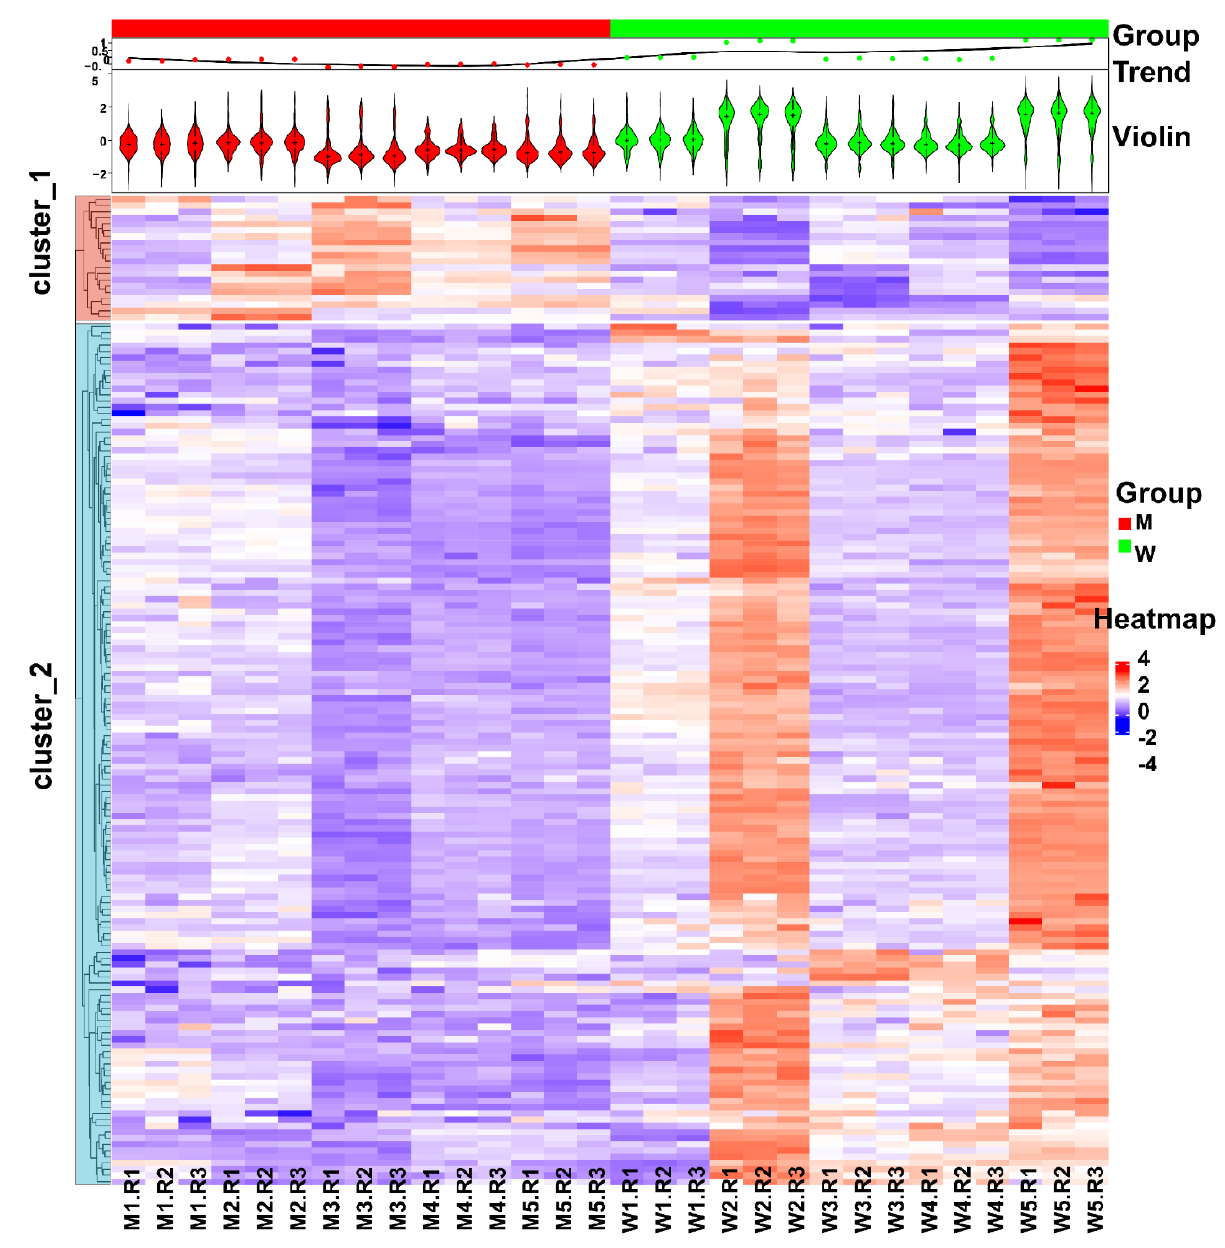
Figure 5. Heatmap analysis of differentially expressed sperm proteins between the M and W groups.